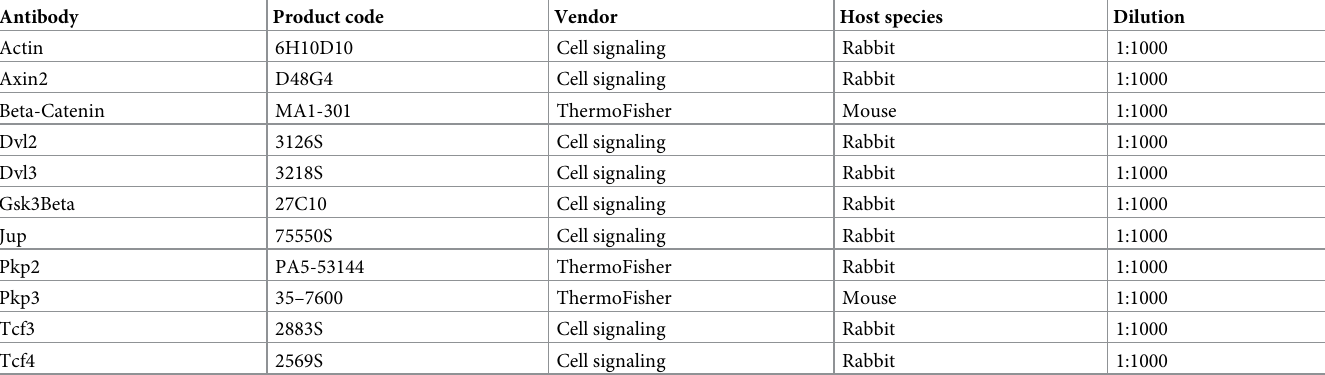
Table 1. List of antibodies used in this study.